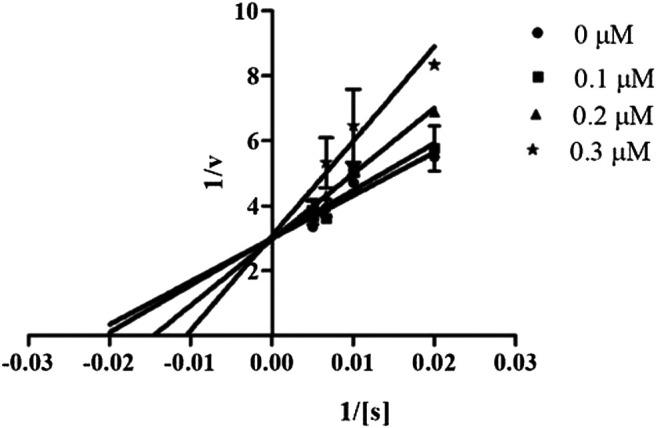
Lineweaver-Burk Plot for h-NTPDase8 inhibitor (8c). S represents the substrate concentration (μM) and concentration of inhibitor (8c) are 0, 0.10, 0.20, and 0.30 μM.